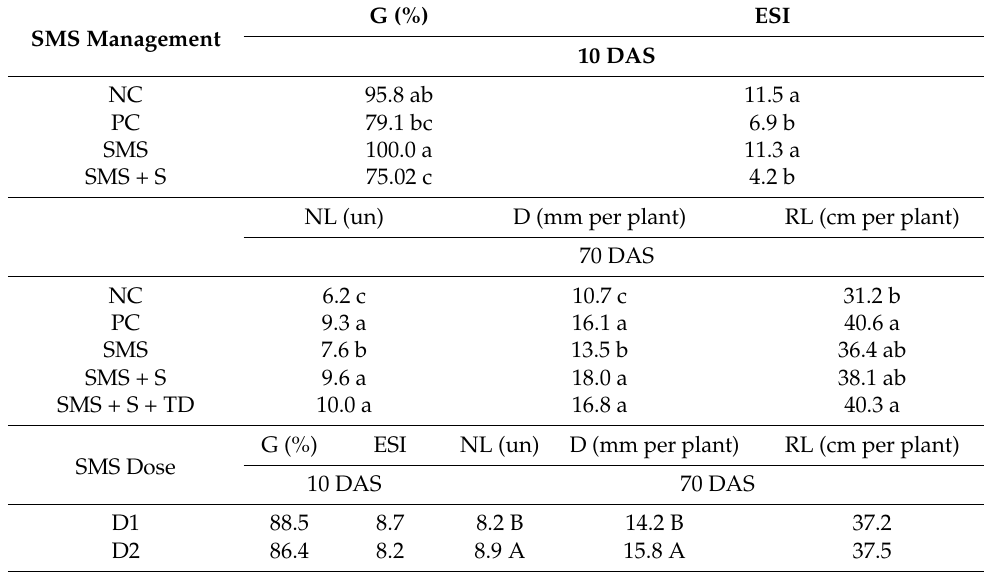
Table 3. Biometric productive data were collected from plants at 10 DAS and 70